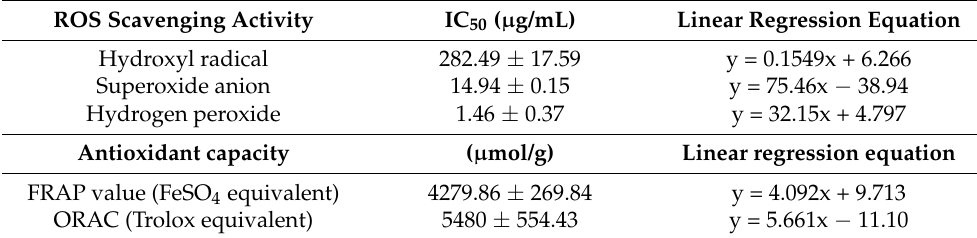
Table 1. The antioxidant activities and antioxidant capacities of PE. ROS Scavenging Activity IC 50 ( µ g/mL) Linear Regression Equation Hydroxyl radical 282.49 ± 17.59 y = 0.1549x + 6.266 Superoxide anion 14.94 ±